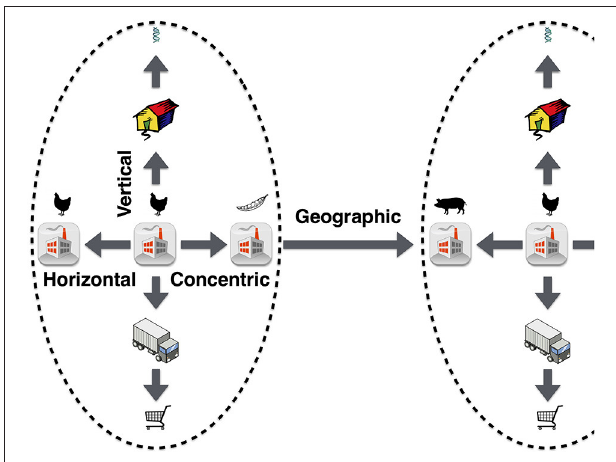
FIGURE 1 | Directions of breaking ownership envelopes by firms to overcome constraints to